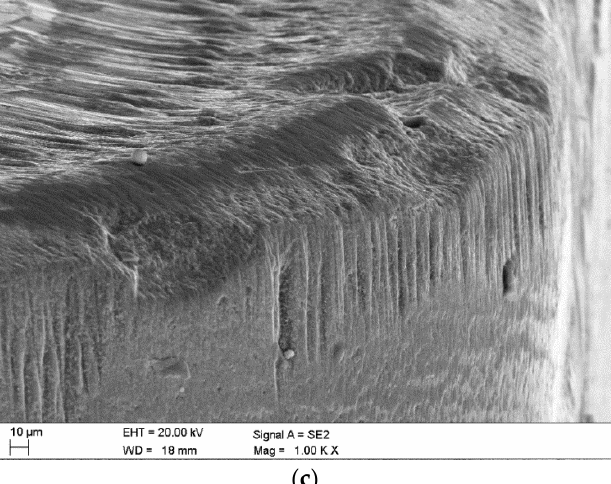
Figure 6. ( a ) Wear character of the cermet substrate with (Ti,Al)N coating after 15 min turning of grey cast iron; ( b ) Wear character of the Al 2 O 3 ceramics reinforced with SiC whiskers after 60 min. turning of spheroidal cast iron; ( c ) Wear character of the uncoated cemented carbide after 3 min. turning of grey cast iron.